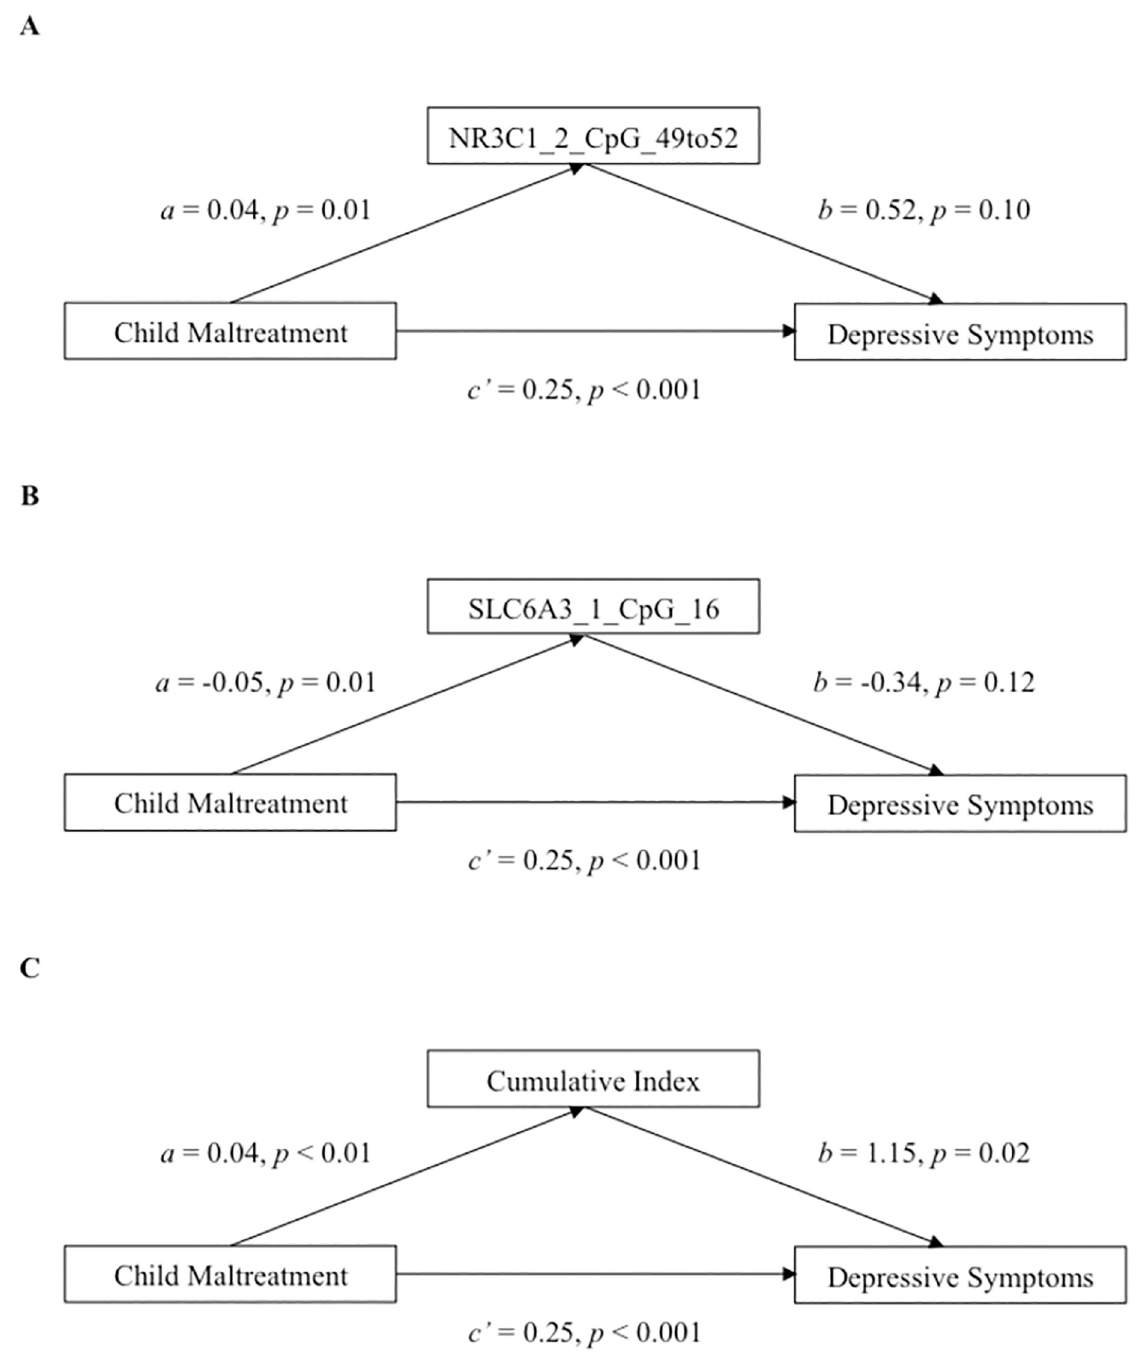
Fig 1. Mediation analyses. (A) Adjusted model for NR3C1_2_CpG_49to52. (B) Adjusted model for SLC6A3_1_CpG_16. (C) Adjusted model for the index of cumulative methylation.